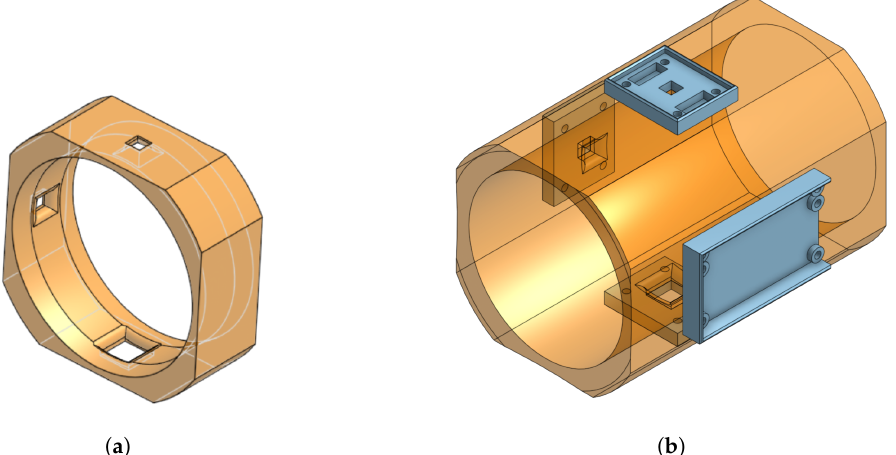
Figure 8. Nephelometric sensor mounts for clear pipes. ( a ) Initial design. ( b ) Revised design including PCB mounts and reduced ambient light.